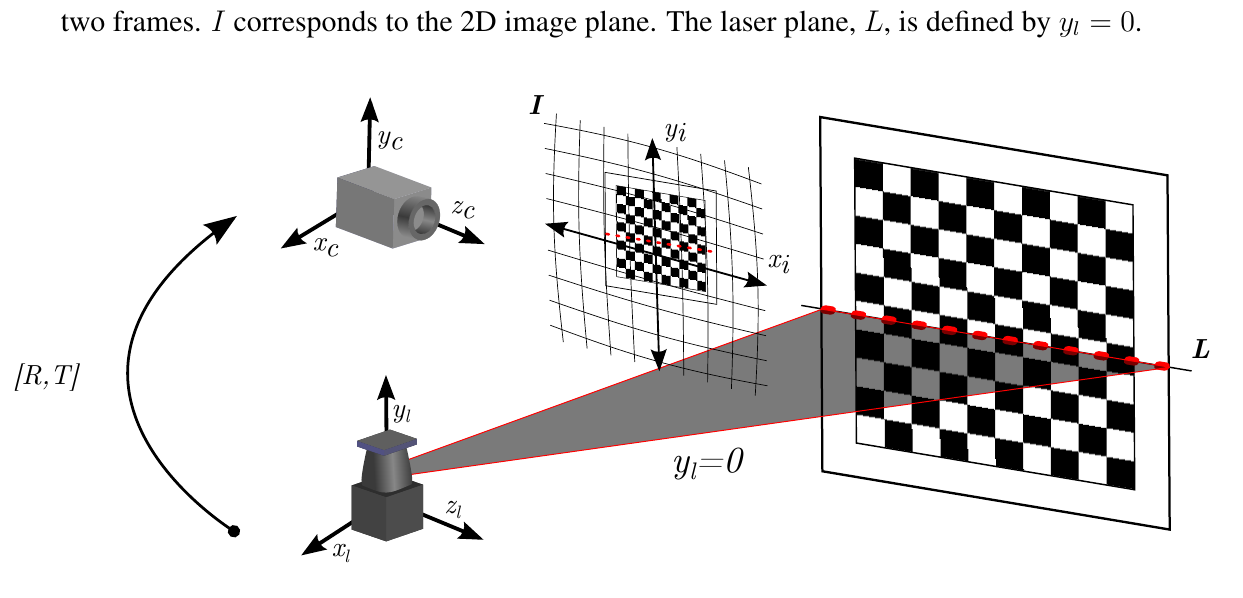
Figure 5. Calibration of the laser and camera. Two reference frames are shown, one with respect to the camera ( x calibration provides the matrices, R, T , containing the rotation and translation between the two frames. I corresponds to the 2D image plane. The laser plane, L , is defined by y